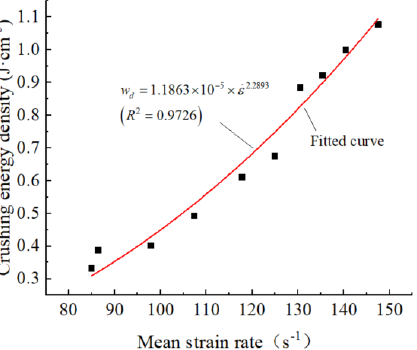
Figure 12. Relationship between crushing energy dissipation density and average strain rate of phyl- lite samples.